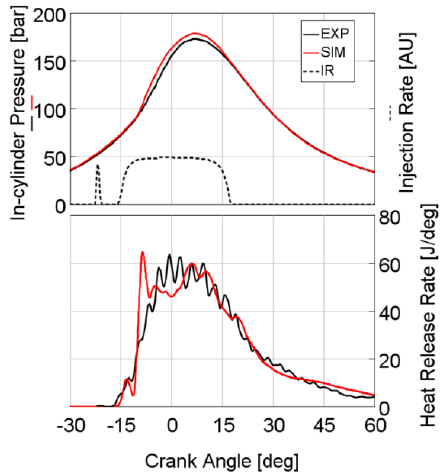
Figure 10. Top: simulated (red) vs experimental (black) in-cylinder pressure, injection rate (dashed black). Bottom: simulated (red) vs experimental (black) Heat Release Rate. WP: 4000 rpm × 18.5 bar BMEP.